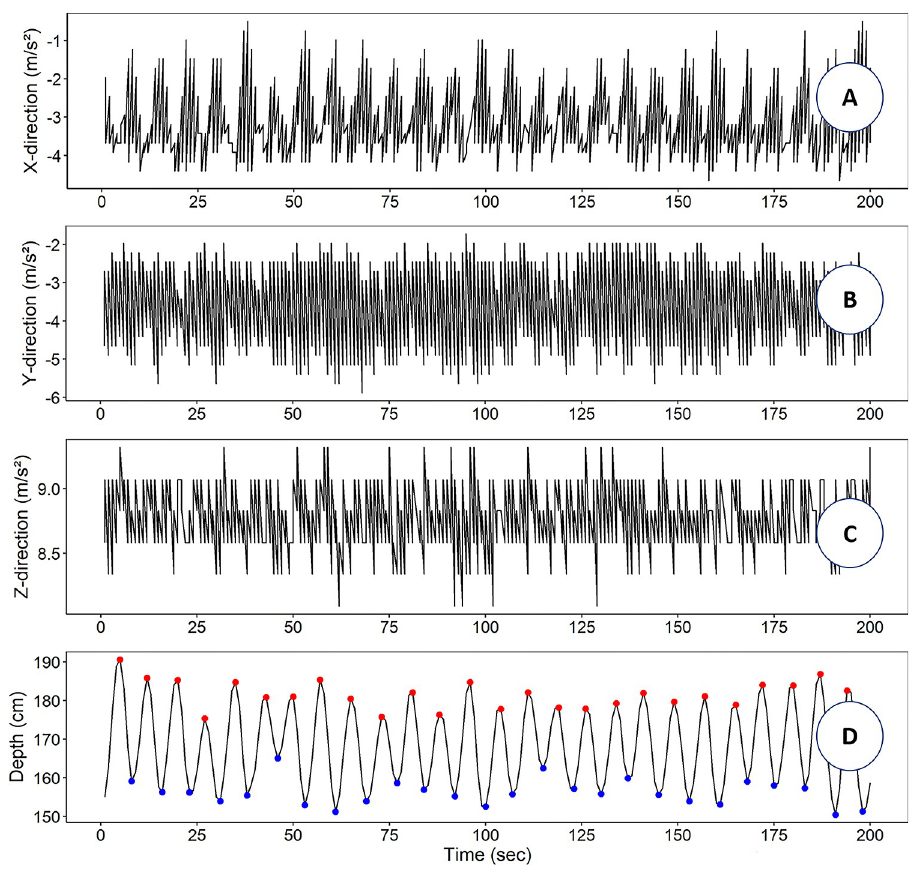
Fig 4. Examples of shaking codend acceleration and depth change in flume tank tests. The first three panels A, B and C are the acceleration values recorded in X, Y, Z directions, respectively. The D panel shows the results of the find_peak analysis applied for depth data to calculate the peak-to-peak amplitude; red points are the peaks and blue points are the valleys for the shaking codend. These examples were taken at a flow velocity of 1.8 kt over 200 secs.